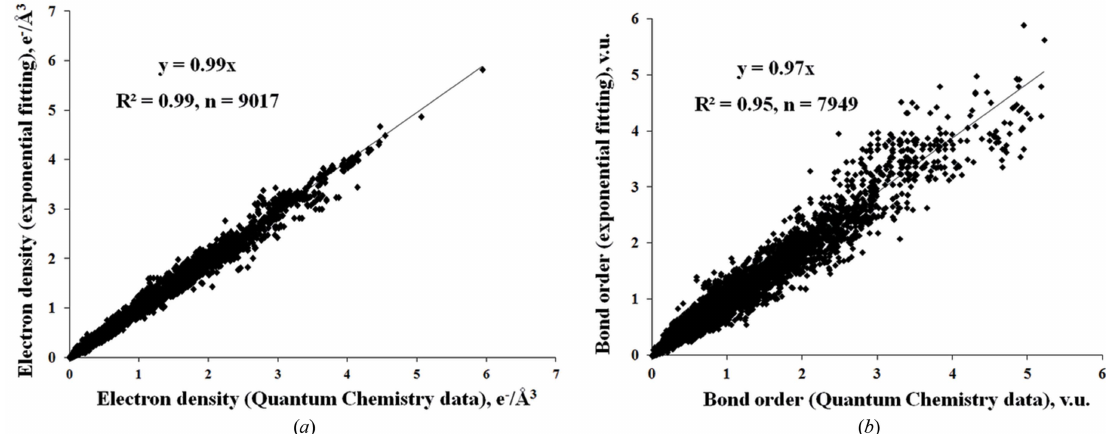
Figure 1 Crystal chemistry versus quantum chemistry results. The electron descriptors ( a ) (cid:2) c( ij ) and ( b ) BO ij , were obtained in this work by exponential fitting of equations (3) and (1), respectively, against the same descriptors calculated by quantum chemistry methods (literature data). n is the number of data